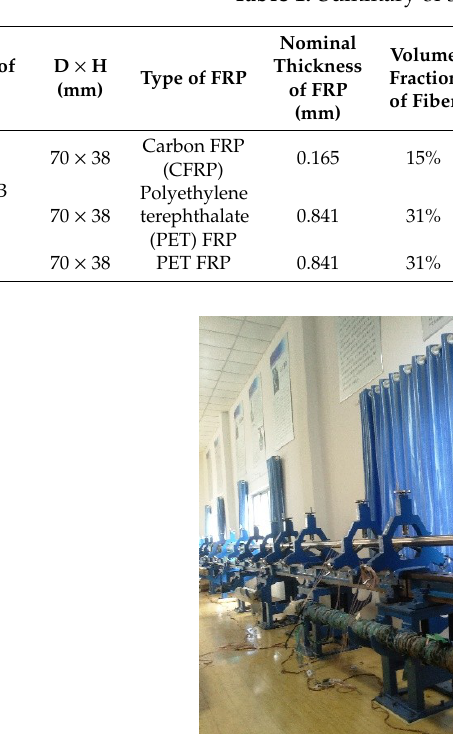
Table 1. Summary of specimens for the SHPB test.